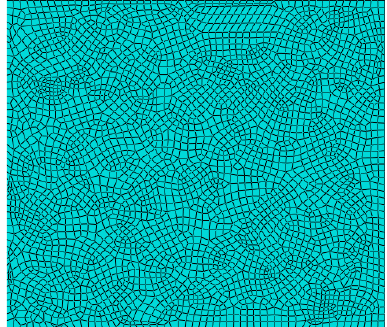
Figure 13. Meshing